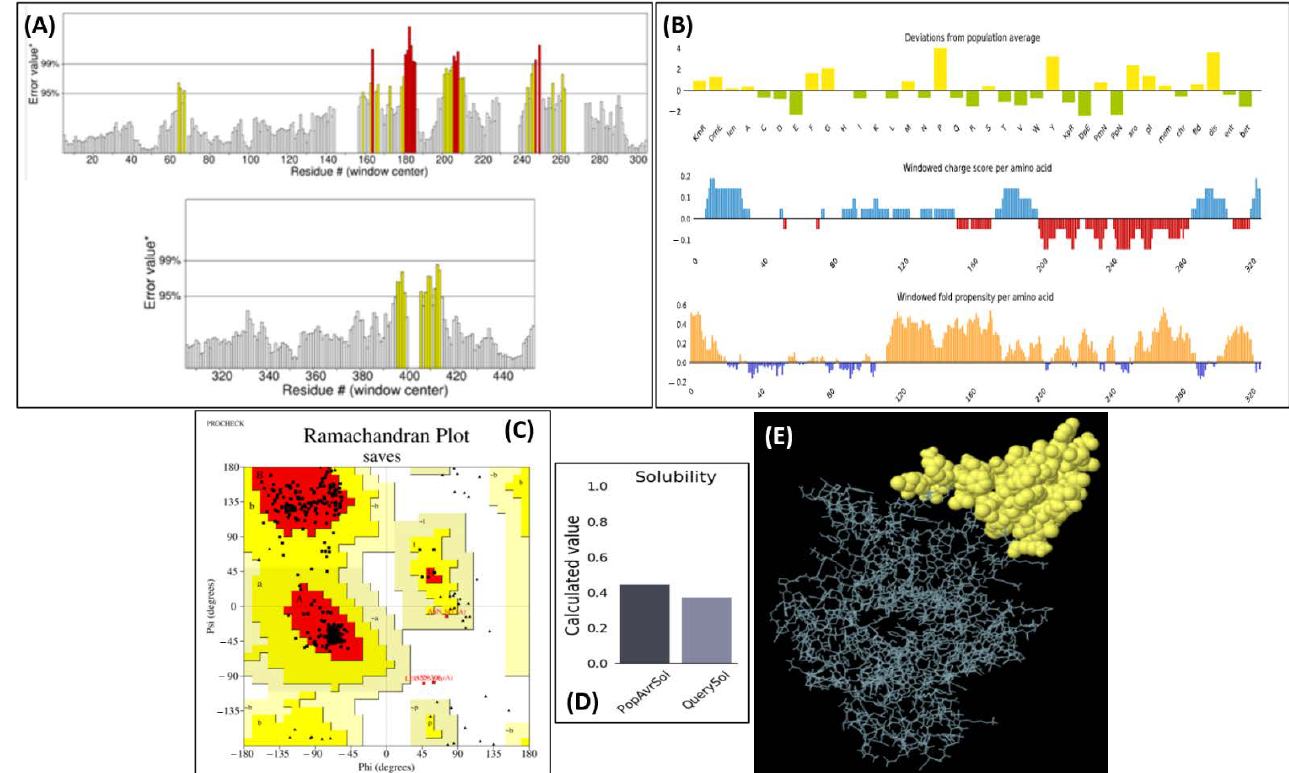
Figure 6. Physicochemical properties of the vaccine; ( A ) ERRAT score of the vaccine construct, ( B ) RC plot of the vaccine construct predicting the secondary structure, ( C ) vaccine solubility as compared with the reference E. coli solubility index, ( D ) tertiary structure of the vaccine’s discontinuous epitopes, and ( E ) solubility index along with fold propensity for the vaccine construct.